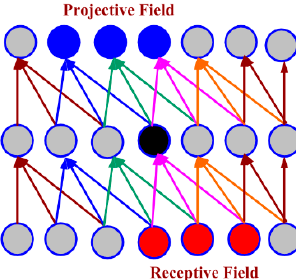
Figure 2. Receptive field and projective field.